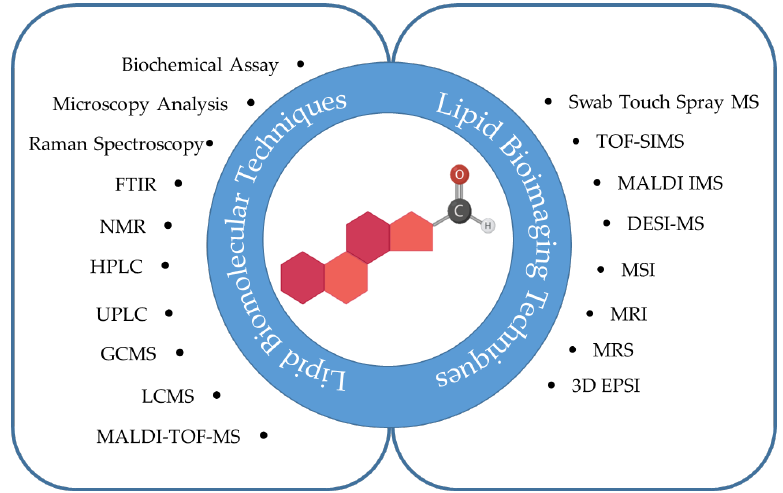
Figure 3. Various analytical techniques were utilised in the included research papers to analyse li- pids in glioma. DESI-MS desorption electrospray ionisation mass spectrometry; FTIR Fourier trans- form infrared; GCMS gas chromatography mass spectrometry; HPLC high-performance liquid chromatography; LCMS liquid chromatography mass spectrometry; MALDI IMS Matrix-assisted